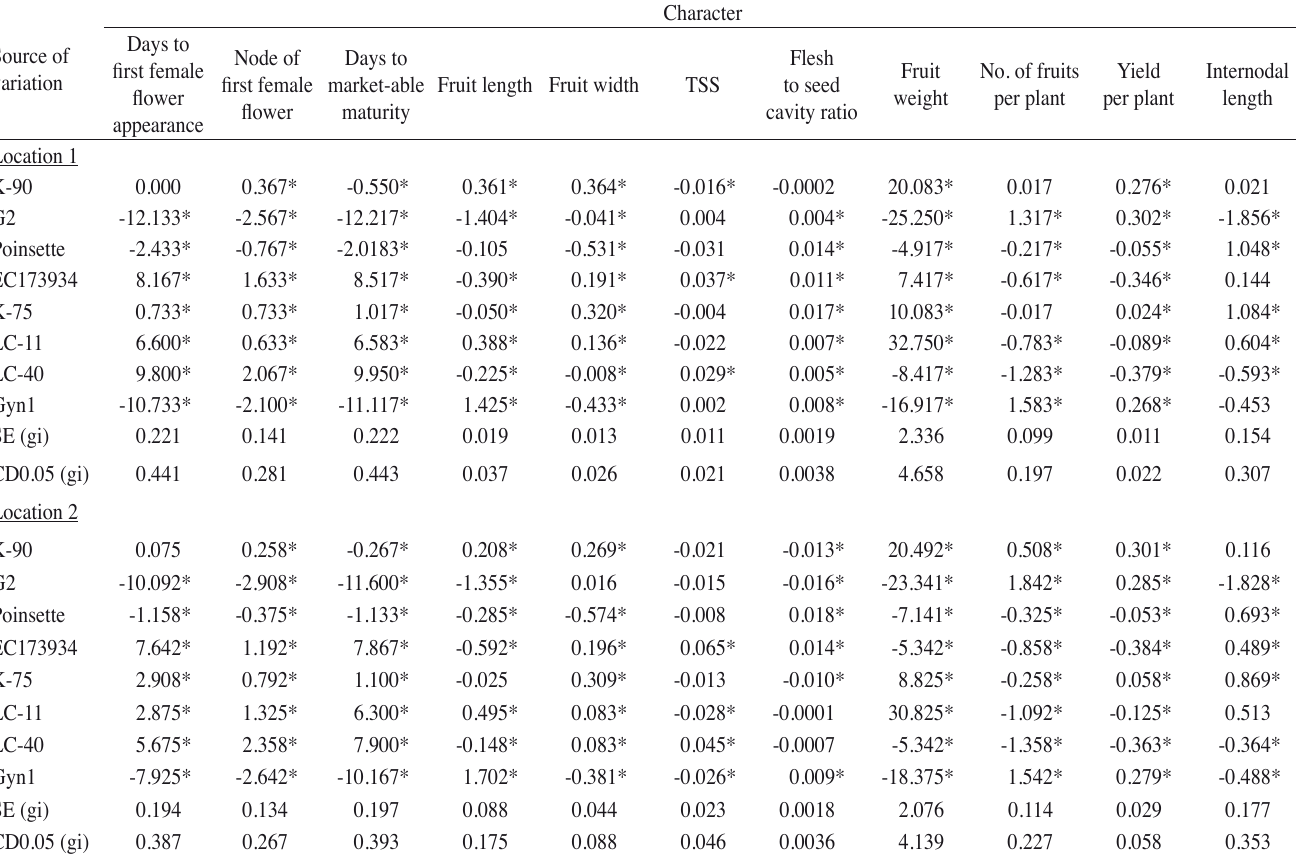
Table 2 - Estimates of general combining ability of parents for different characters in cucumber